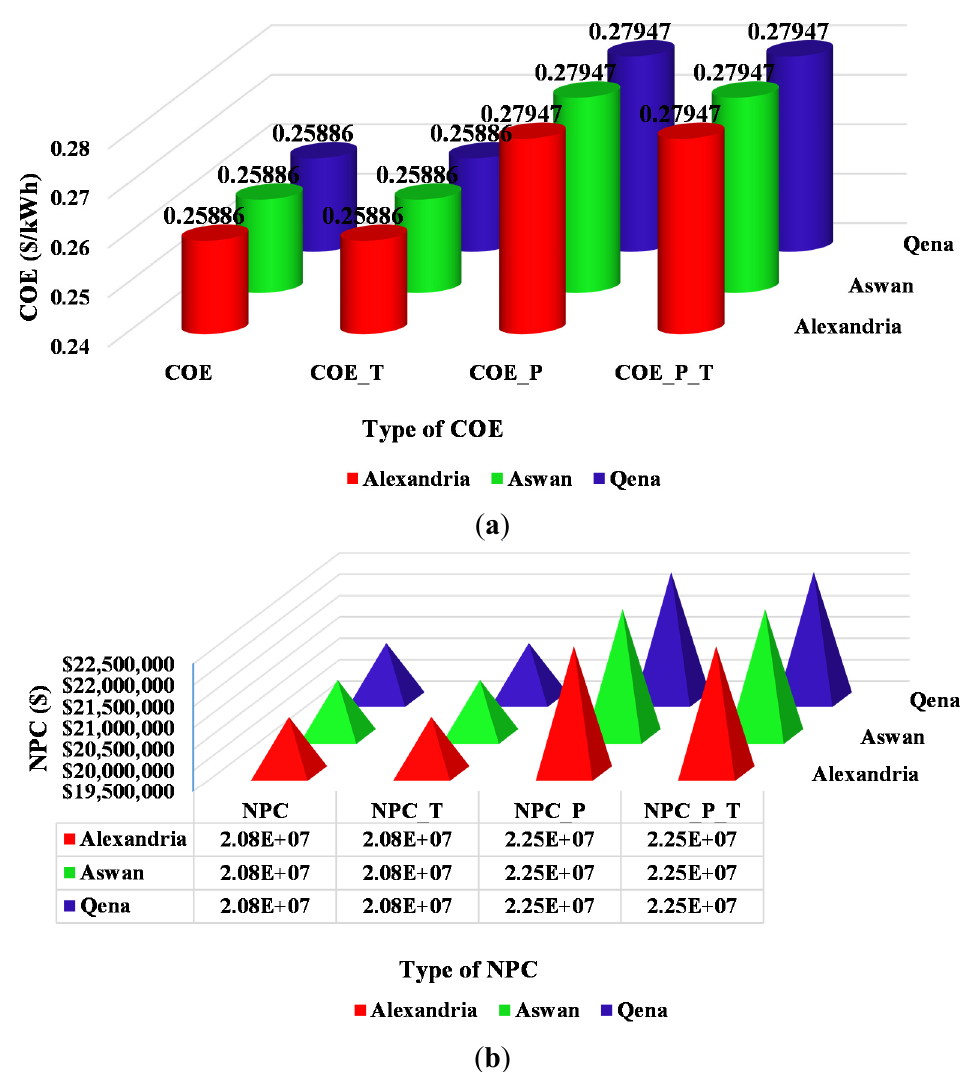
Figure 11. ( a ) The different COE of diesel/battery system in Alexandria, Aswan and Qena; ( b ) The different NPC of diesel/battery system in Alexandria, Aswan and